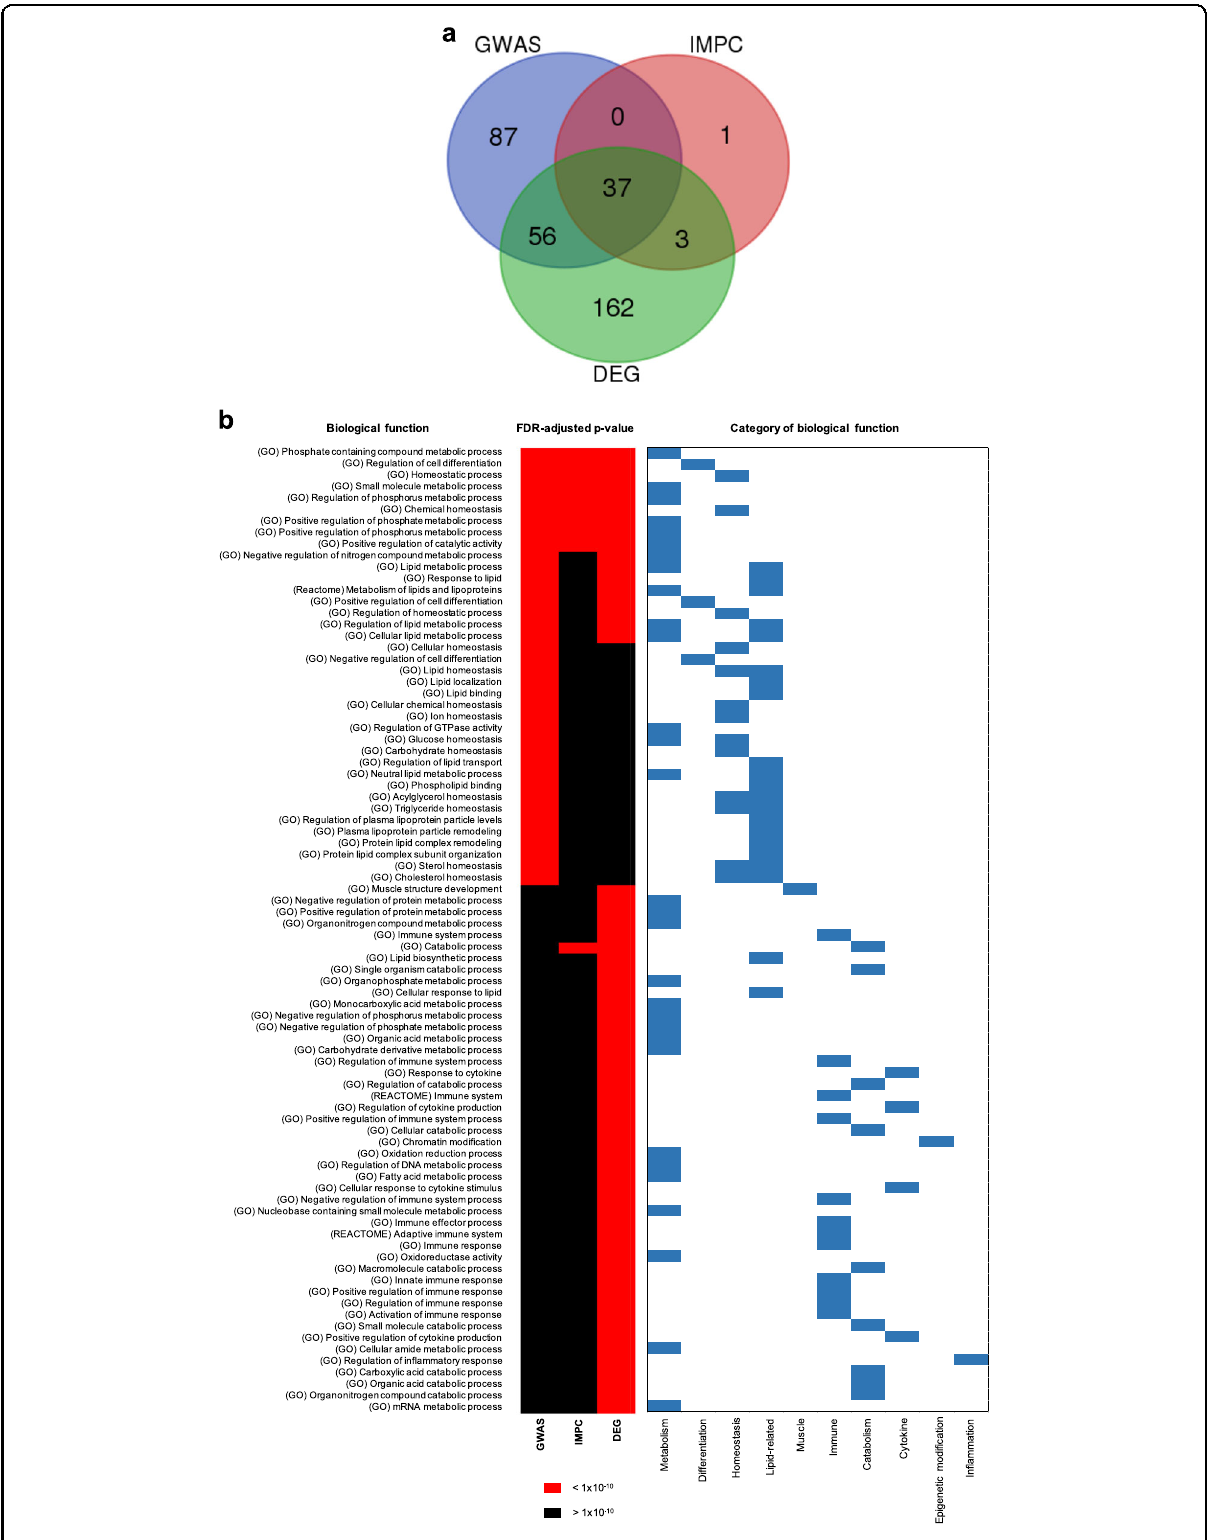
Fig. 5 Biological functions that are very strongly enriched (FDR-adjusted p -value < 1E10-10) in the list of obesity/T2D-related genes from each data type . a The Venn diagram of the very strongly enriched biological functions. b Very strongly enriched biological functions for at least one data type, while being relevant to Obesity/T2D-relevant. For each biological function, its related functional categories are also